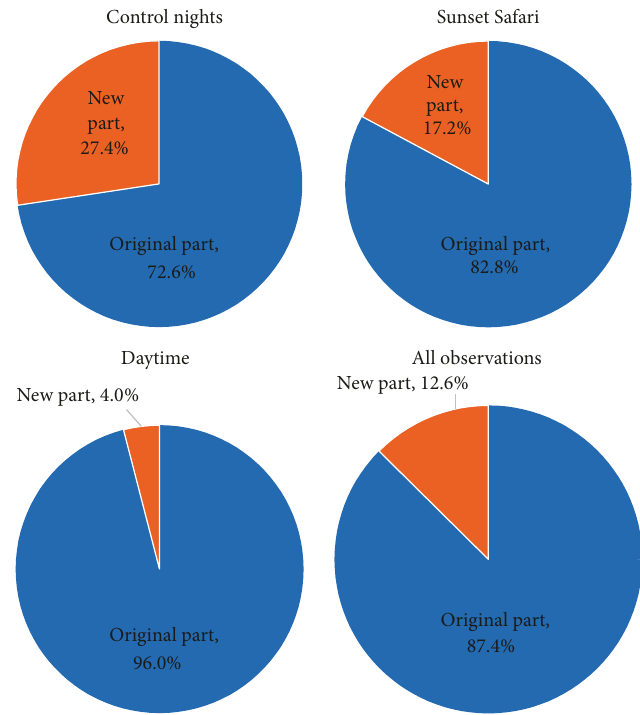
Figure 6: General enclosure use for each observation period and for all